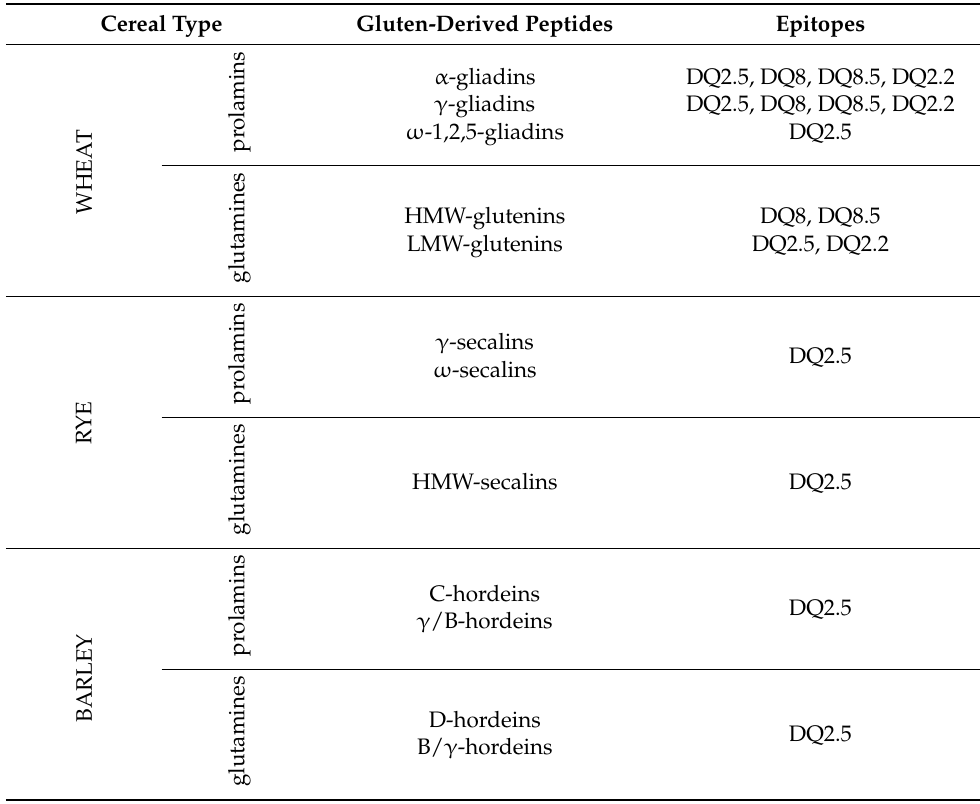
Table 1. Classification of different gluten immunogenic peptides and relevant T-cell epitopes. Cereal Type Gluten-Derived